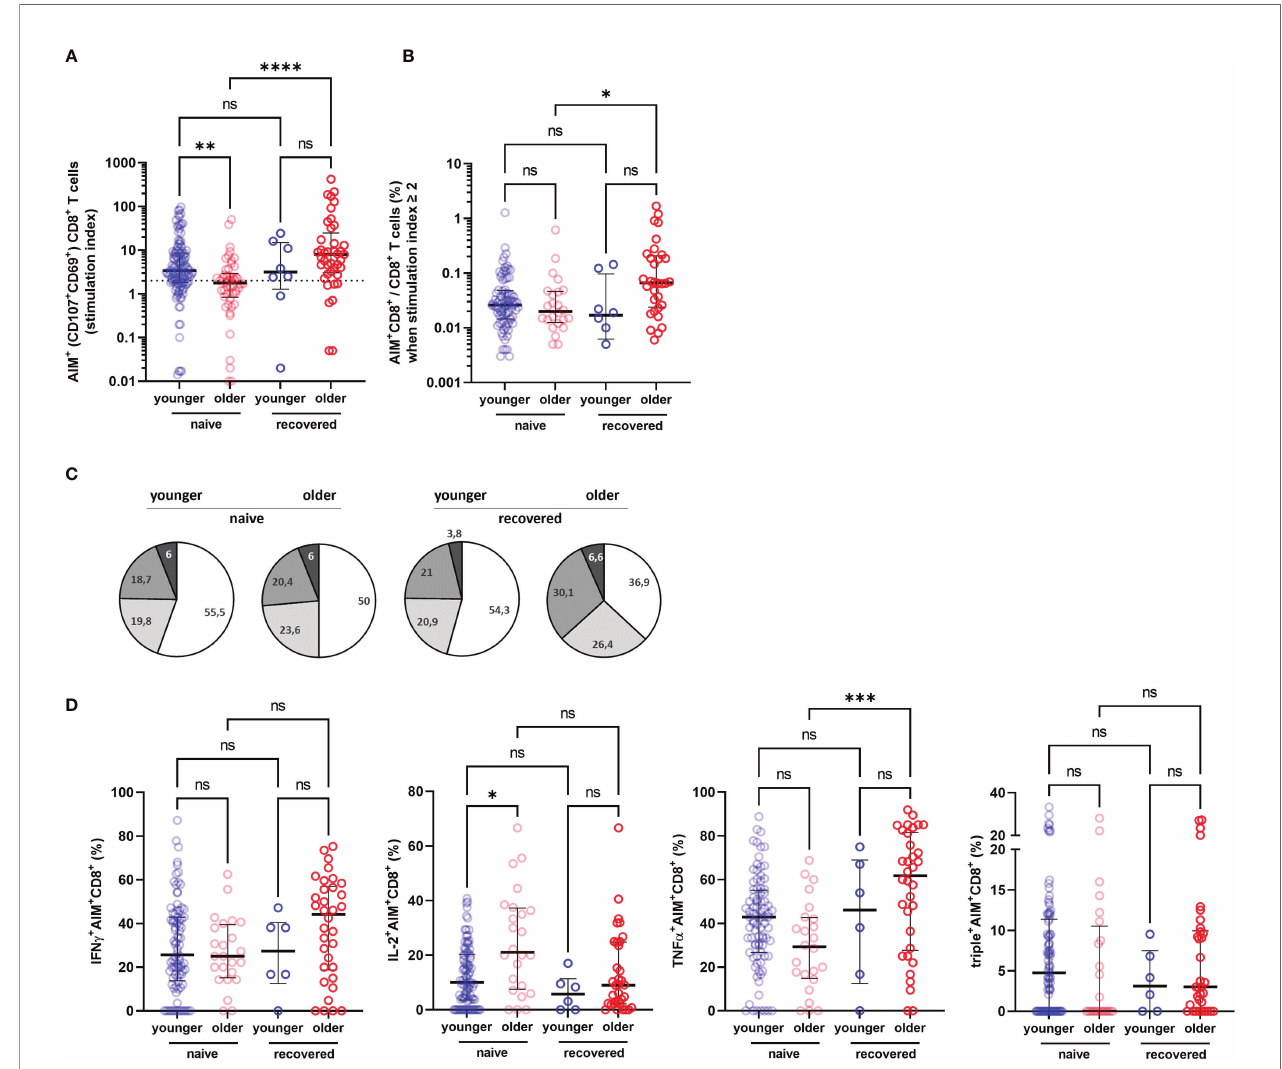
FIGURE 6 | Speci fi c CD8 + T-cell response in older and in young adults 3 months after the fi rst injection of BNT162b2. (A) Speci fi c CD8 + T cells according to activation-induced markers (AIM), reported with their stimulation index. (B) Percentage of AIM + CD8 + T cells among total CD8 + T cells in responders, i.e., participants with a stimulation index ≥ 2. (C) Pie charts representing the relative proportions of AIM + CD8 + T cells producing none (white), one (light grey), two (medium grey), or three cytokines (dark grey) out of INF g , IL-2, and TNF a according to participant group and past history of COVID-19 (naive and recovered). (D) Proportion of AIM + CD4 + cells producing IFN g , IL-2, TNF a , and proportion of IFN g + IL-2 + TNF a + (triple + ) CD4 + T cells according to participant group and past history of COVID-19 (naive and recovered). (COVID-19-naive young adults n = 113, COVID-19-naive older n = 48, COVID-19-recovered young n = 8, COVID-19-recovered older n = 41; median [interquartile range (IQR)] are shown). * p -values < 0.05; ** p -values < 0.01; *** p -values < 0.001; **** p -values < 0.0001; ns, not signi fi cant. AIM + , cell- expressing activation-induced